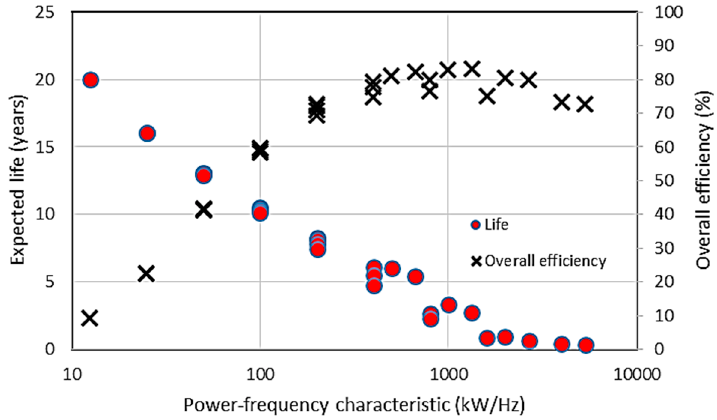
Figure 13. Expected battery life and overall efficiency vs. power-frequency characteristic.